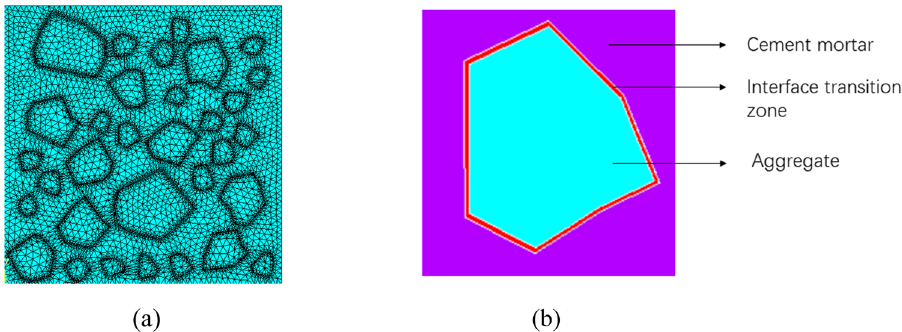
Figure 1: Two - dimensional random aggregate model: ( a ) FEM 1 and ( b ) mesophase material composition.